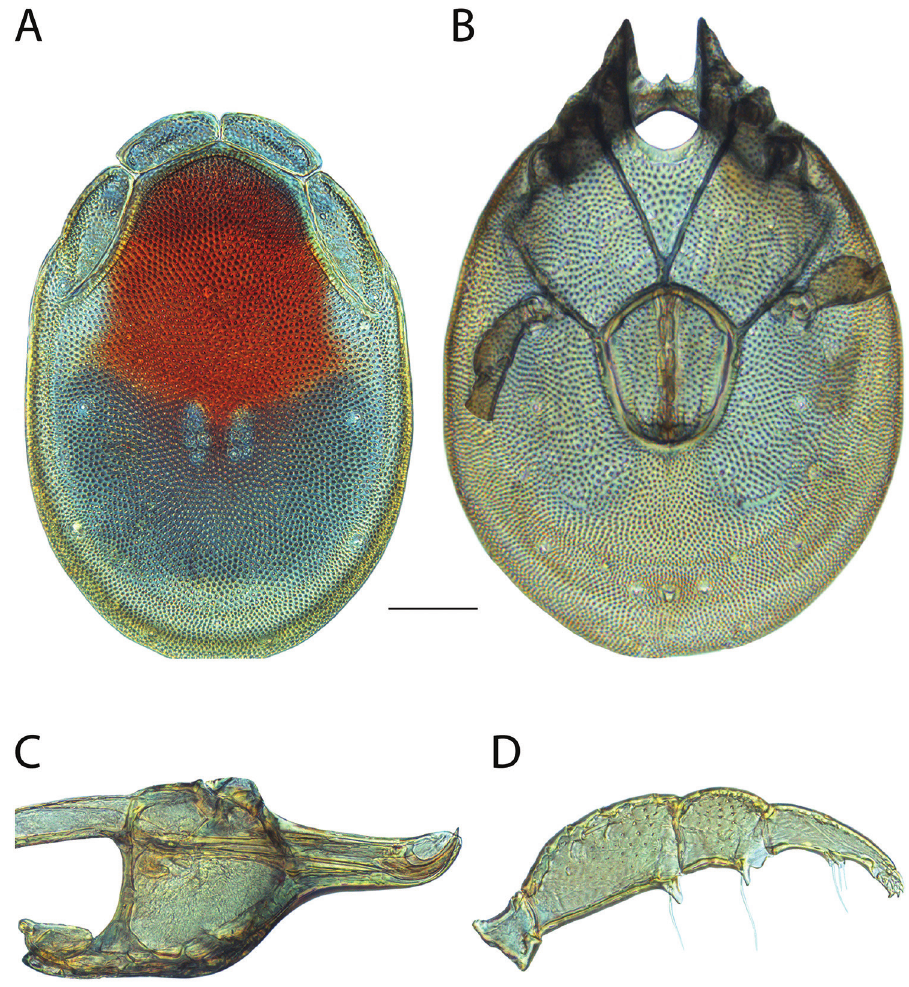
Figure 203. Torrenticola pulchra sp. n. female: A dorsal plates B venter (legs removed) C subcapitulum D pedipalp (setae not accurately depicted). Scale = 100